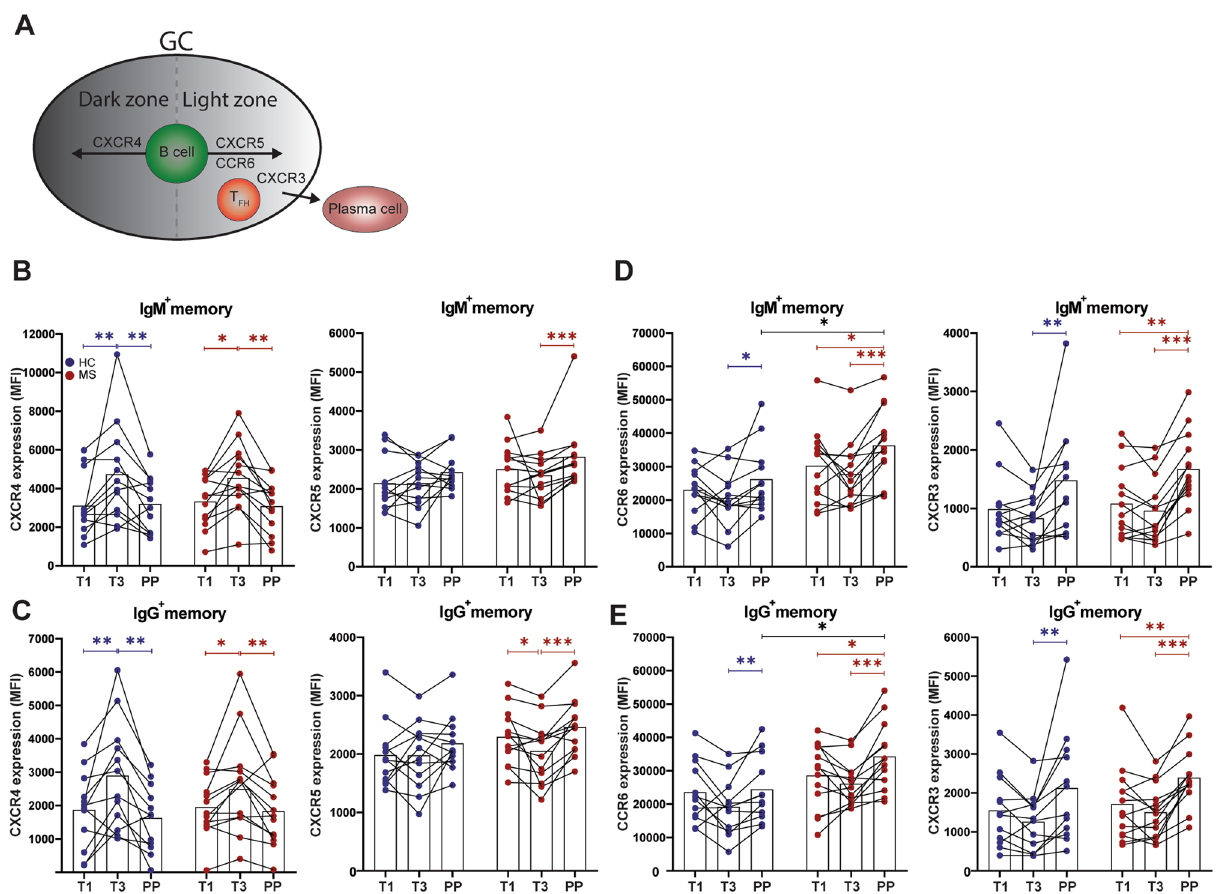
Figure 2. Chemokine receptor expression on circulating memory B cells during and early after pregnancy in MS patients and healthy controls. ( A ) Schematic display of chemokine receptors involved in GC-dependent organization and maturation of B cells. Expression of dark zone-associated CXCR4 and light zone-associated CXCR5, CCR6 and CXCR3 was compared between IgM + ( B,D ) and IgG + ( C,E ) memory B cells from first trimester (T1), third trimester (T3) and postpartum (PP) samples from 13 MS patients without a postpartum relapse (red) and 12 HC (blue). Wilcoxon signed-rank test was performed to compare the different gestational periods. Two-way ANOVA with Bonferroni’s multiple comparison test was performed to compare HC with MS patients. * p < 0.05, ** p < 0.01, *** p < 0.001, **** p <